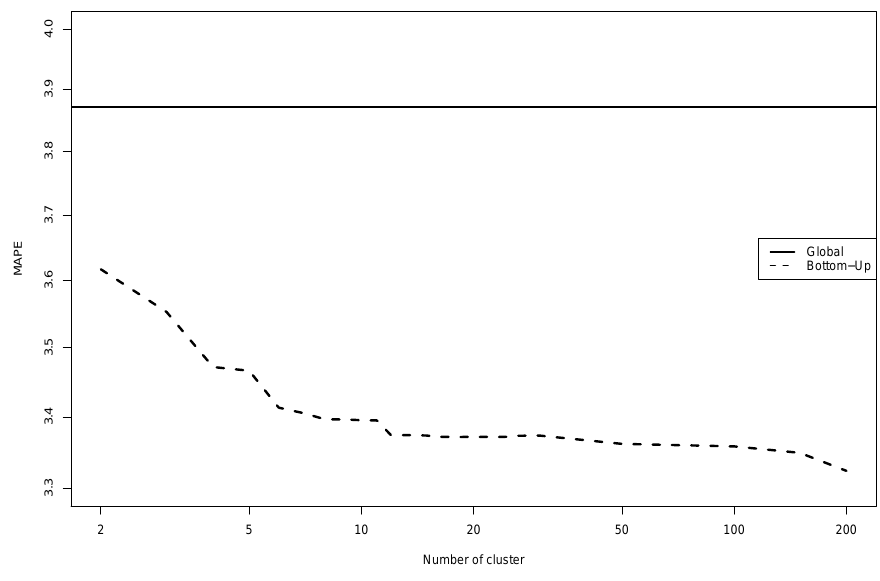
Figure 13. MAPE for the aggregate demand by number of classes for the two strategies: direct global demand forecast (full) and bottom-up forecast